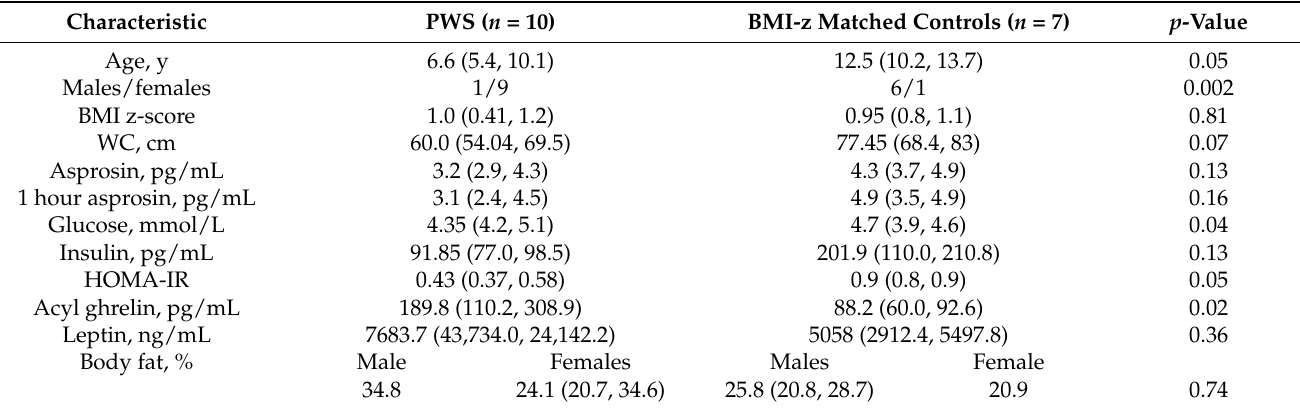
Table 2. Baseline characteristics of children with Prader–Willi syndrome (PWS) and BMI-z matched